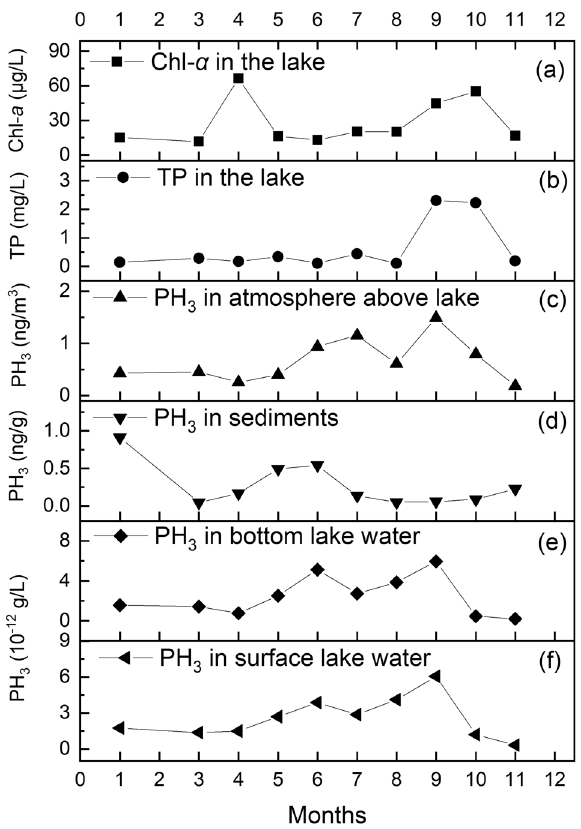
Fig. 3 Variations of PH 3 distribution, total phosphorus (TP) and Chl- ɑ concentration in Taihu Lake 25,35,85 . ( a ) TP dry deposition rate in the lake; ( b ) PH 3 in atmosphere above the lake; ( c ) Chl- ɑ concentration in the lake; ( d ) PH 3 in surface lake water; ( e ) PH 3 in bottom lake water; and ( f ) PH 3 in